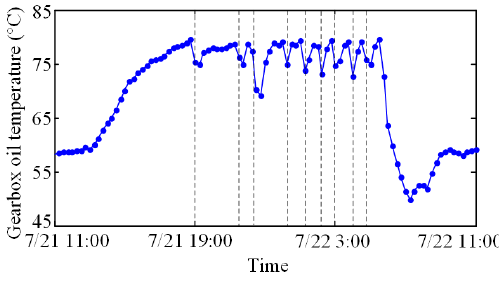
Figure 21. Time series of gearbox oil temperature.